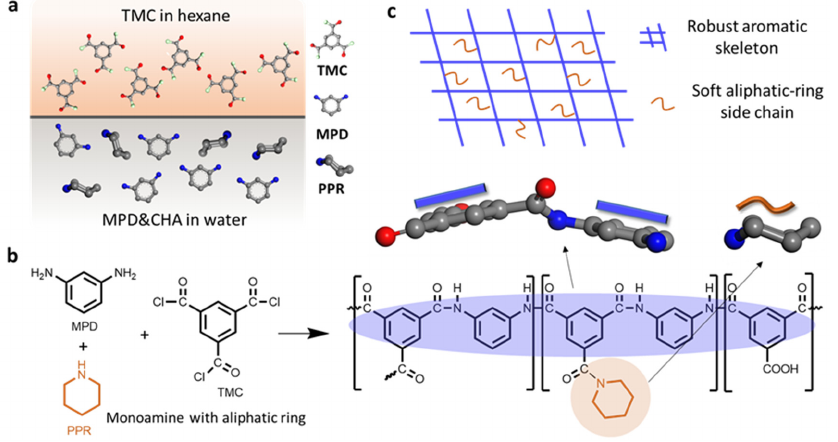
Figure 1. Illustration of the rigid–flexible coupling strategy for the fabrication of a high-performance RO membrane. ( a ) Visualization of interfacial polymerization between TMC and MPD and PPR; ( b ) synthesis of the polyamide consisting of a robust aromatic polyamide skeleton and a soft aliphatic- ring side chain; ( c ) schematic diagram of the rigid–flexible coupling polyamide network.